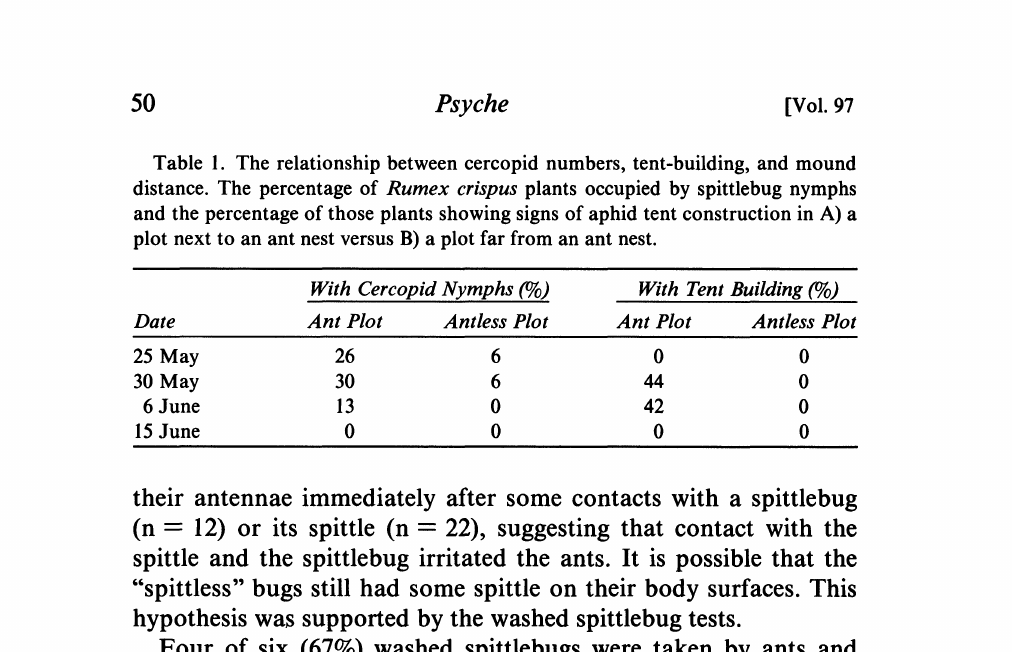
Table 1. The relationship between cercopid numbers, tent-building, and mound distance. The percentage of Rumex erispus plants occupied by spittlebug nymphs and the percentage of those plants showing signs of aphid tent construction in A) a plot next to an ant nest versus B) a plot far from an ant